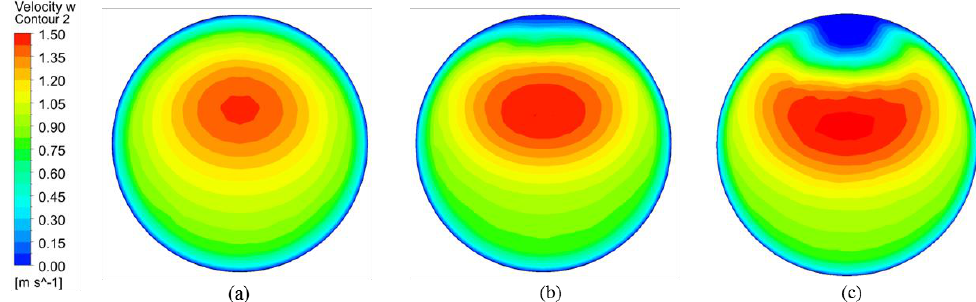
Figure 8. Velocity w contour at the surface of Line (E), hematocrit is 58%, anastomosis angle of ( a ), ( b ), and ( c ) are 15°, 30°m and 45°, respectively.